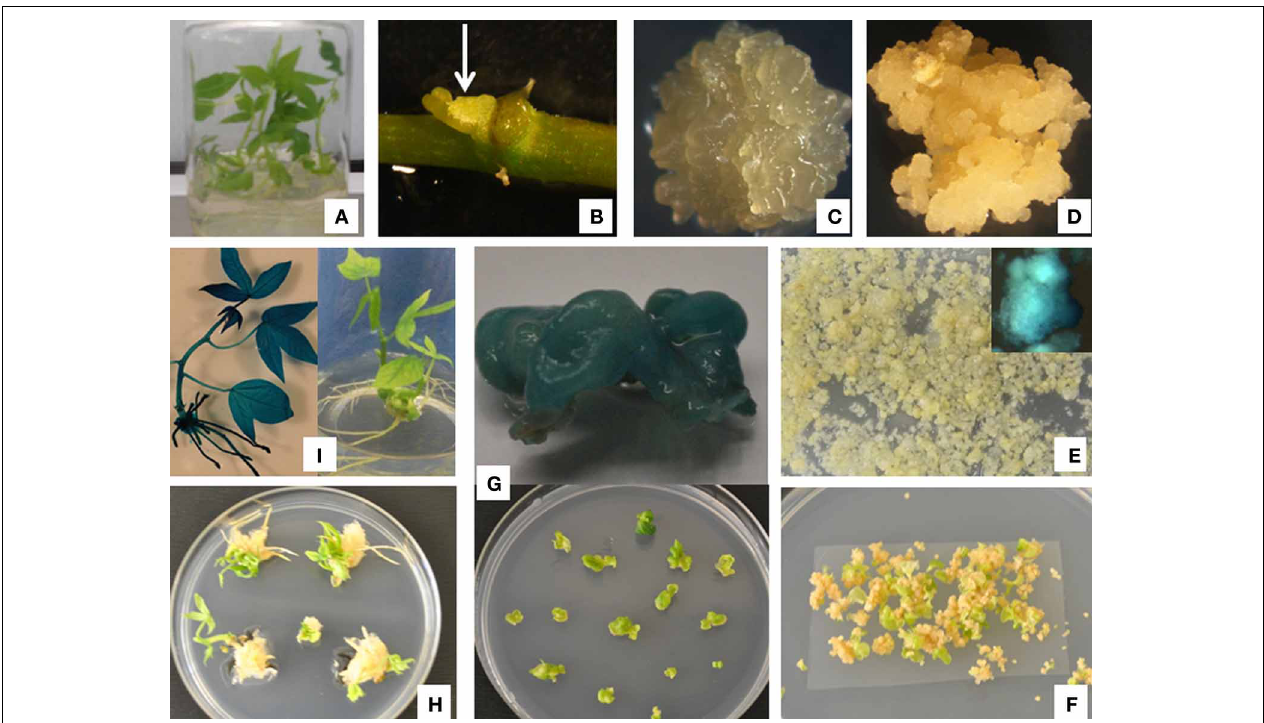
FIGURE 1 | Agrobacterium -mediated transformation of cassava cultivar Serere using FEC. (A) In vitro shoot culture; (B) axillary bud (arrow); (C) primary somatic embryos; (D) friable embryogenic callus; (E) Agrobacterium -inoculated FEC proliferating on selective medium and transient GUS assay (upper right corner); (F) somatic embryos/cotyledons on